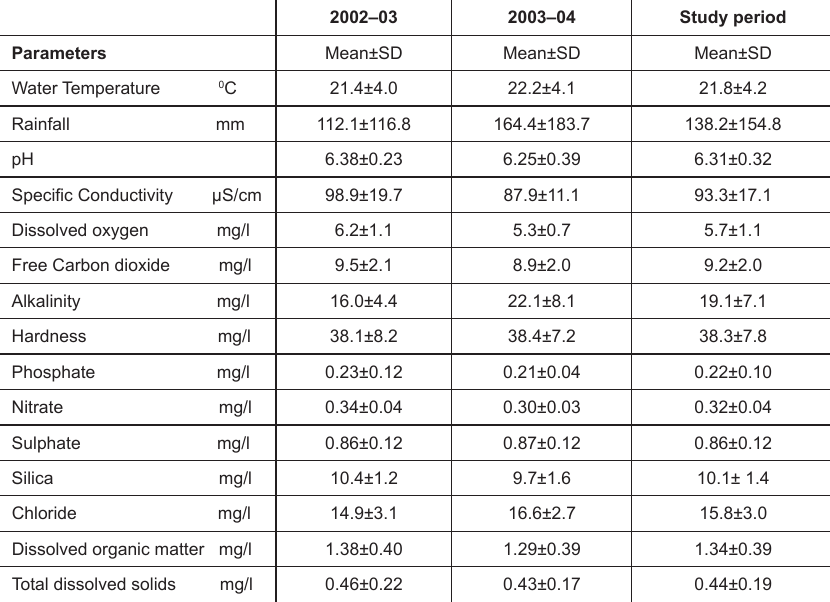
Table 1. Abiotic factors of Loktak Lake